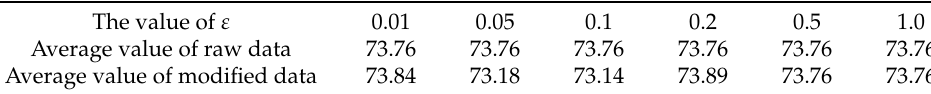
Table 4. Query results under different values of ε